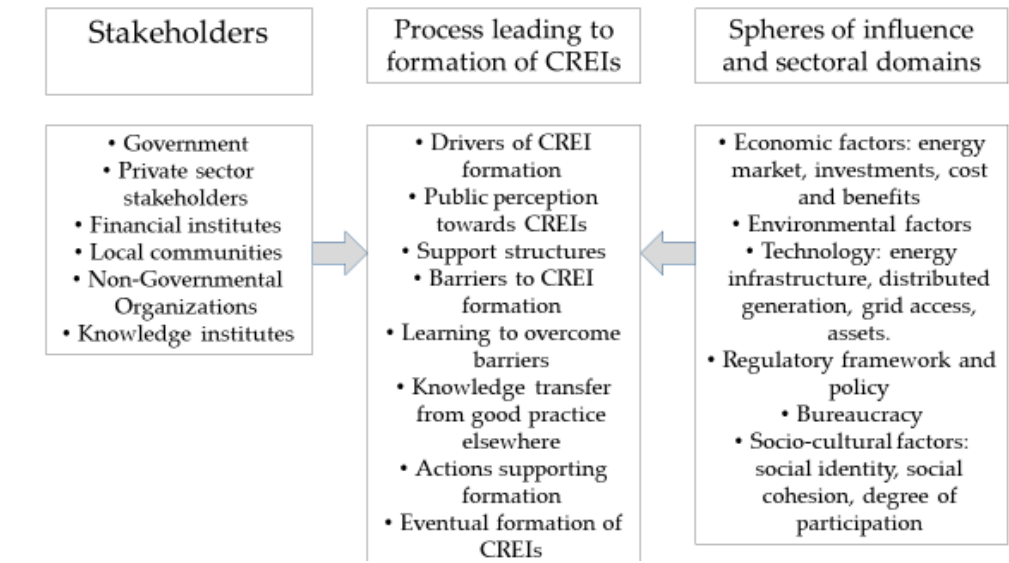
Figure 1. Conceptual framework CREI formation; partly adapted from [50].